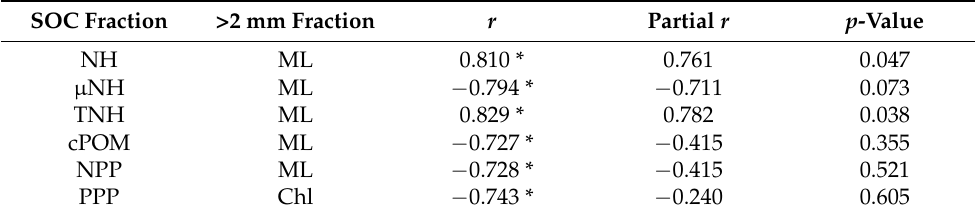
Table 6. Pearson’s correlation coefficients ( r ) for soil organic carbon fractions and the mineral phase, controlling the effects of soil organic